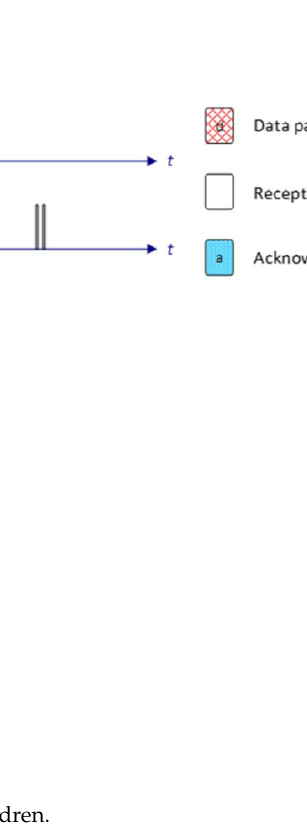
Figure A1. Link layer broadcast in ContikiMAC.